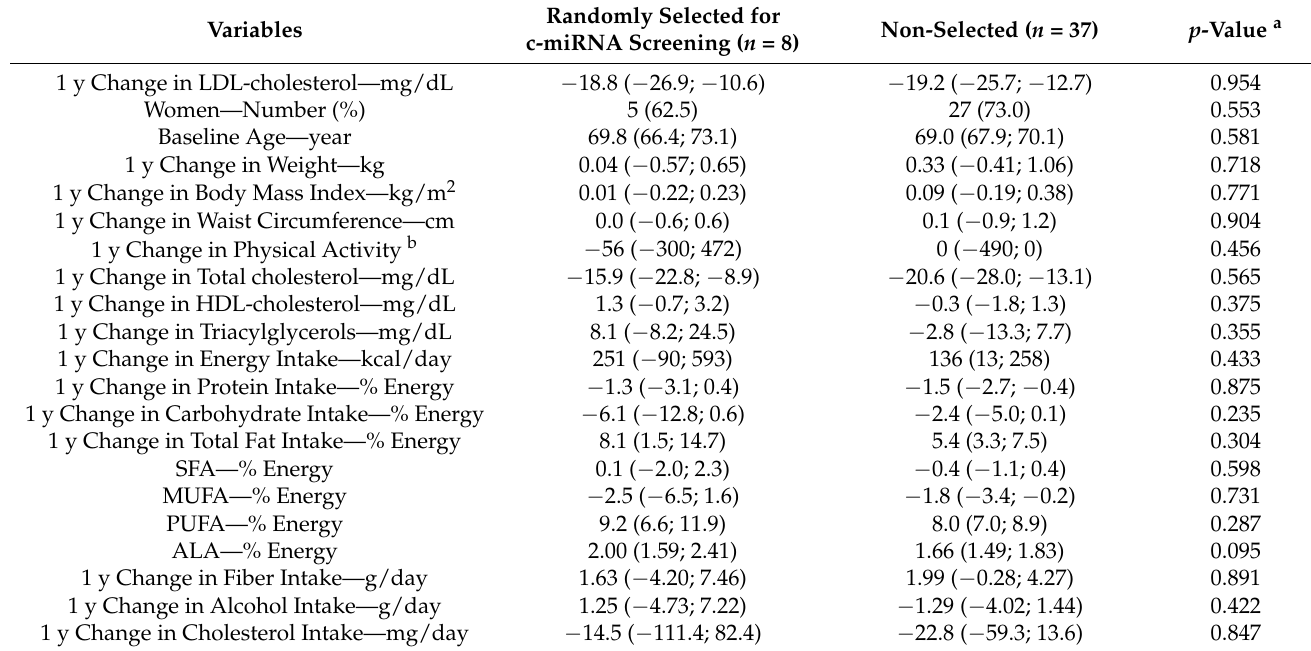
Table 3. Demographic, adiposity, and dietary data in LDL-c responders after 1 y walnut supplemen- tation by selection to undergo c-miRNA screening